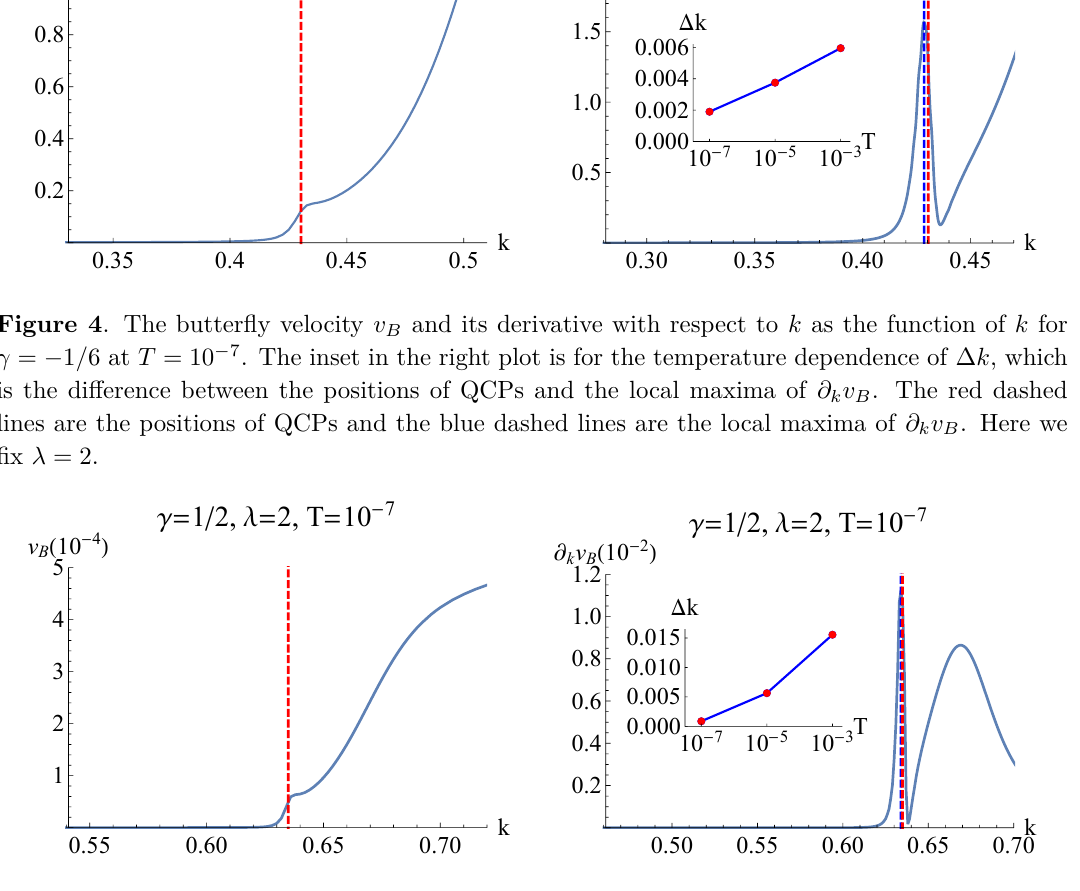
Figure 5 . The butterfly velocity v B and its derivative with respect to k as the function of k for γ = 1 / 2 at T = 10 − 7 . The inset in the right plot is for the temperature dependence of ∆ k , which is the difference between the positions of QCPs and the local maxima of ∂ lines are the positions of QCPs and the blue dashed lines are the local maxima of ∂ fix λ = 2